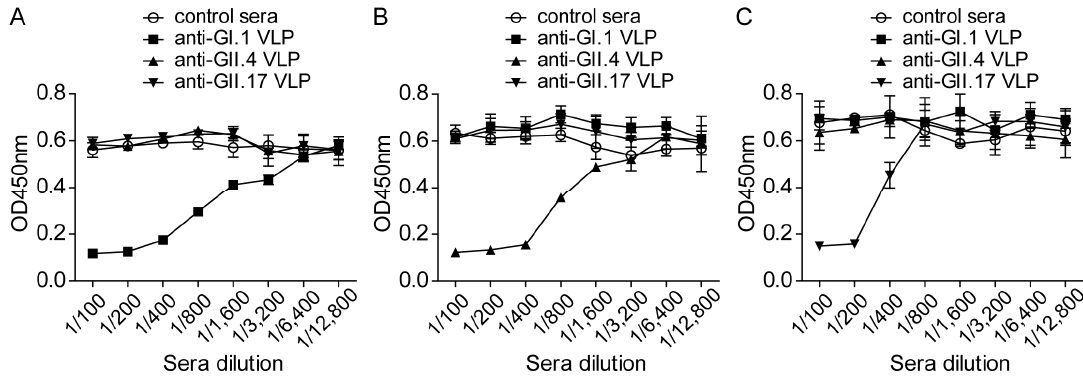
Figure 5. Inhibition of the norovirus virus-like particle (NoV VLP) attachment to 293T-FUT2 cells. NoV VLPs were preincubated with serially diluted mouse antisera for 1 h at 37 °C, and the resulting VLP/antisera mixtures were added to 293T-FUT2 cells. The attached VLPs were detected with VLP-specific rabbit antisera. ( A ) GI.1 VLP-specific antisera inhibited GI.1 VLP attachment to 293T-FUT2 cells; ( B ) GII.4 VLP-specific antisera inhibited GII.4 VLP attachment to 293T-FUT2 cells; ( C ) GII.17 VLP-specific antisera inhibited GII.17 VLP attachment to 293T-FUT2 cells. The enterovirus 71 (EV71) VLP-specific antisera were used as negative control sera. Data are the means ± SD of OD 450nm values for triple wells. All of the experiments were replicated three times.